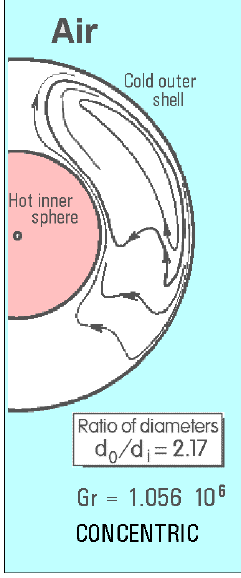
Fig. 11. An example of convection streaming trajectories between concentric spheres, of which the inner one is heated. The pathlines (streamlines do not exist in this case) shown here were obtained by adapting the photographs presented in [6]. Note that shown here is the case of Grasshoff number Gr of the order. This is a value at which the streaming is unsteady and its trajectories vary in time.